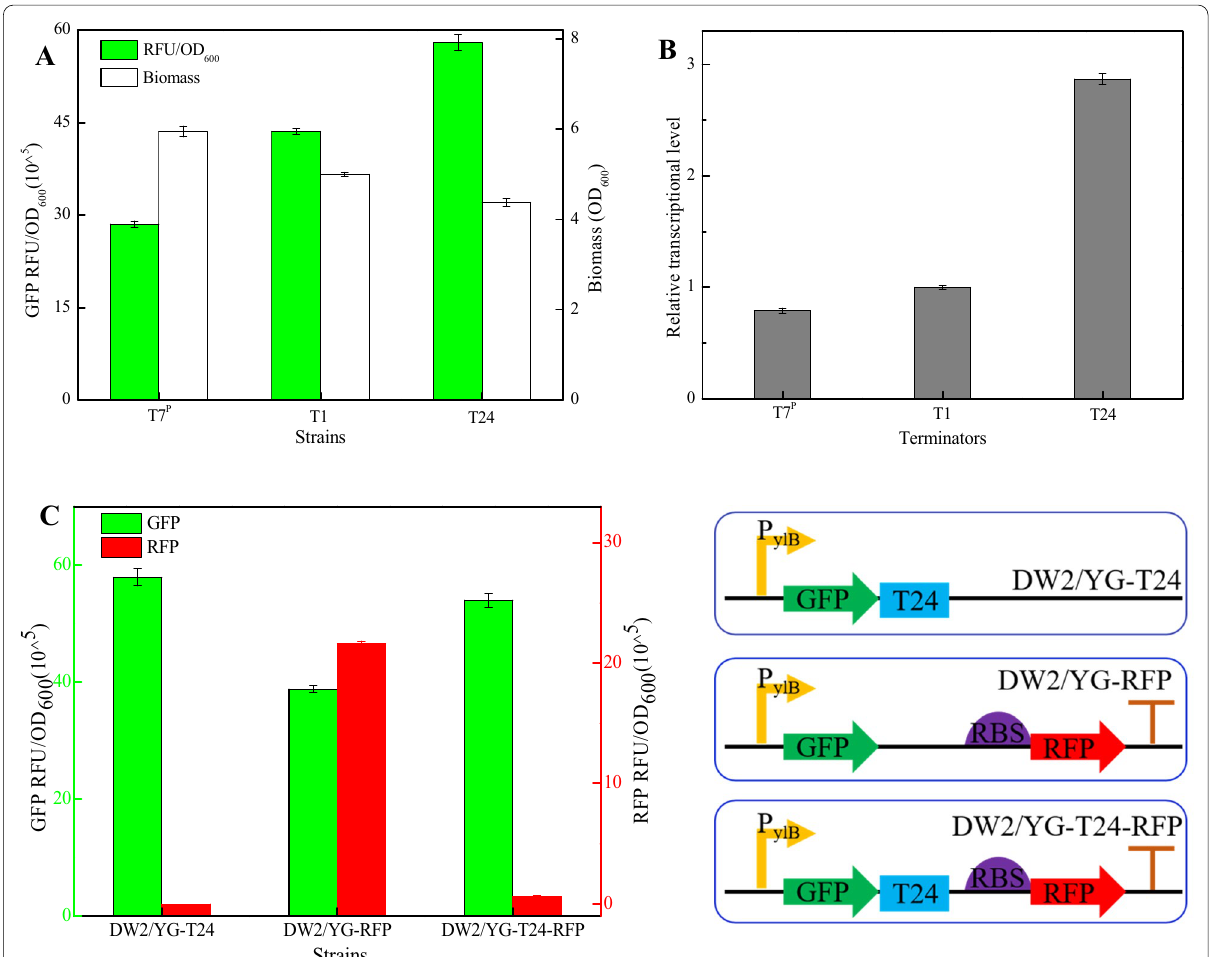
Fig. 5 Manually design and verification of the best terminator T24. A Green fluorescence intensities and cell biomasses of strains with different terminators (T1, T24, and T7 P ). B Relative transcriptional levels of gfp . C: Determination of termination efficiency of terminator T24